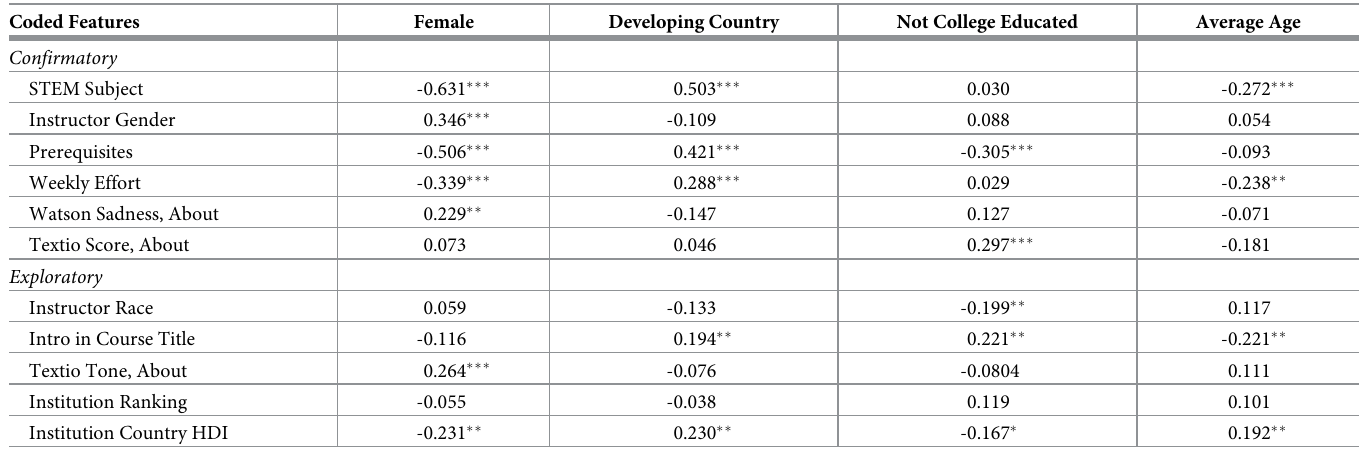
Table 3. Confirmatory and exploratory findings in the edX sample.